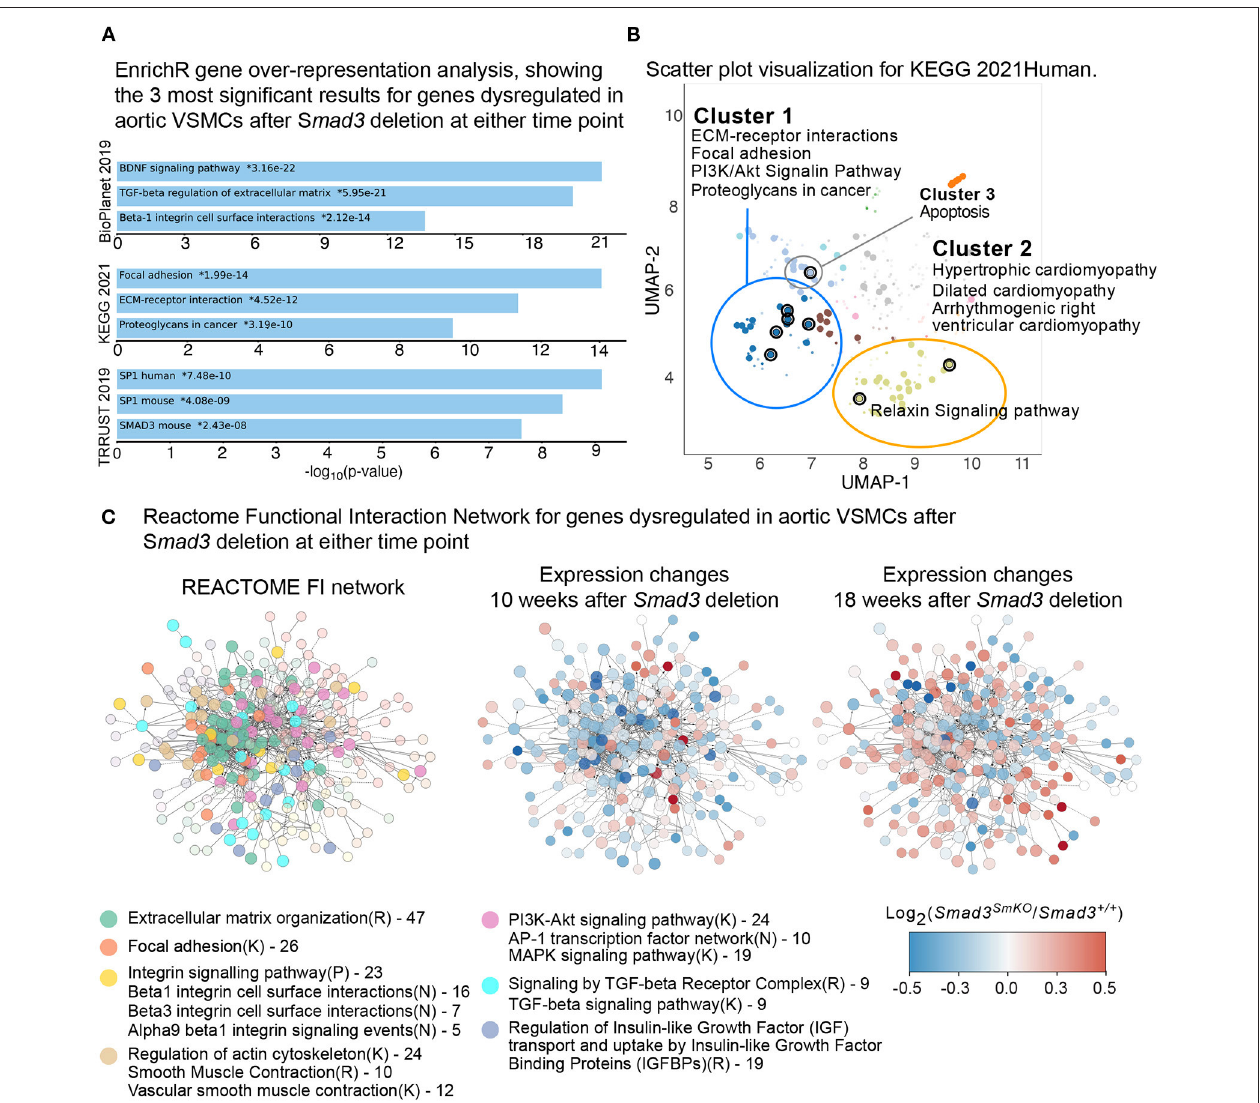
FIGURE 3 | Defective expression of extracellular matrix and focal adhesions components in Smad3 -deficient VSMCs. (A) EnrichR gene over-representation analysis, showing the top 3 most significant results in the BioPlanet 2019, KEGG 2021, and TRRUST 2019 databases for genes dysregulated in aortic VSMCs after S mad3 deletion at either time point. (B) Scatter plot visualization of top dysregulated KEGG 2021 pathways in VSMCs after S mad3 deletion. Similar gene sets are clustered together, and larger, black-outlined points represent significantly enriched terms. Clusters were computed using the Leiden algorithm and points plotted on the first two UMAP dimensions by the EnrichR web application. (C) Dysregulated transcripts were converted to their human orthologue and analyzed using the REACTOME Functional Interaction (FI) Gene Set enrichment pipeline, which yielded a main network of approximately 300 transcripts. Each node represents a dysregulated gene in Smad3- deficient VSMCs. Nodes were manually colored-coded based on the main enriched pathway they belonged to, as indicated in the legend. R indicates a REACTOME pathway, K a KEGG and N and NCI Pathway Interaction Database; numbers listed in the legend represent number of transcripts belonging to the indicated group. The same network of dysregulated genes is also shown computationally colored based on corresponding transcript expression at 10- and 18-weeks post-deletion. Genes shown in blue are downregulated and genes shown in red are upregulated in Smad3 SmKO relative to